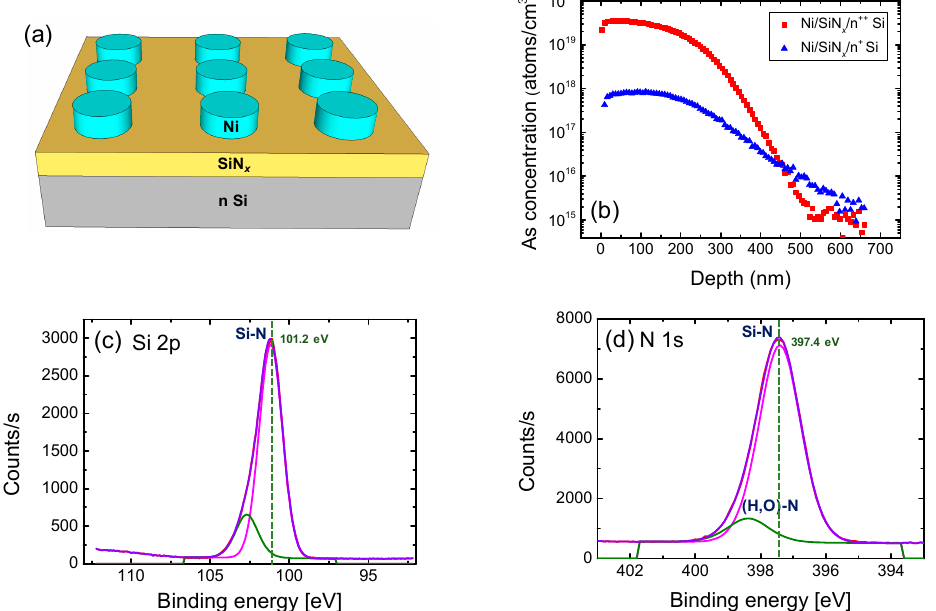
Figure 1. ( a ) Schematic drawing of Ni/SiN x /n-Si device; ( b ) Secondary ion mass spectrometry depth profile of the Si bottom electrode of the high and low dopant concentration sample; X-ray photoelectron spectroscopy (XPS) spectra of the SiN x film deposited via low-pressure chemical vapor deposition (LPCVD): ( c ) Si 2p and ( d ) N 1s.